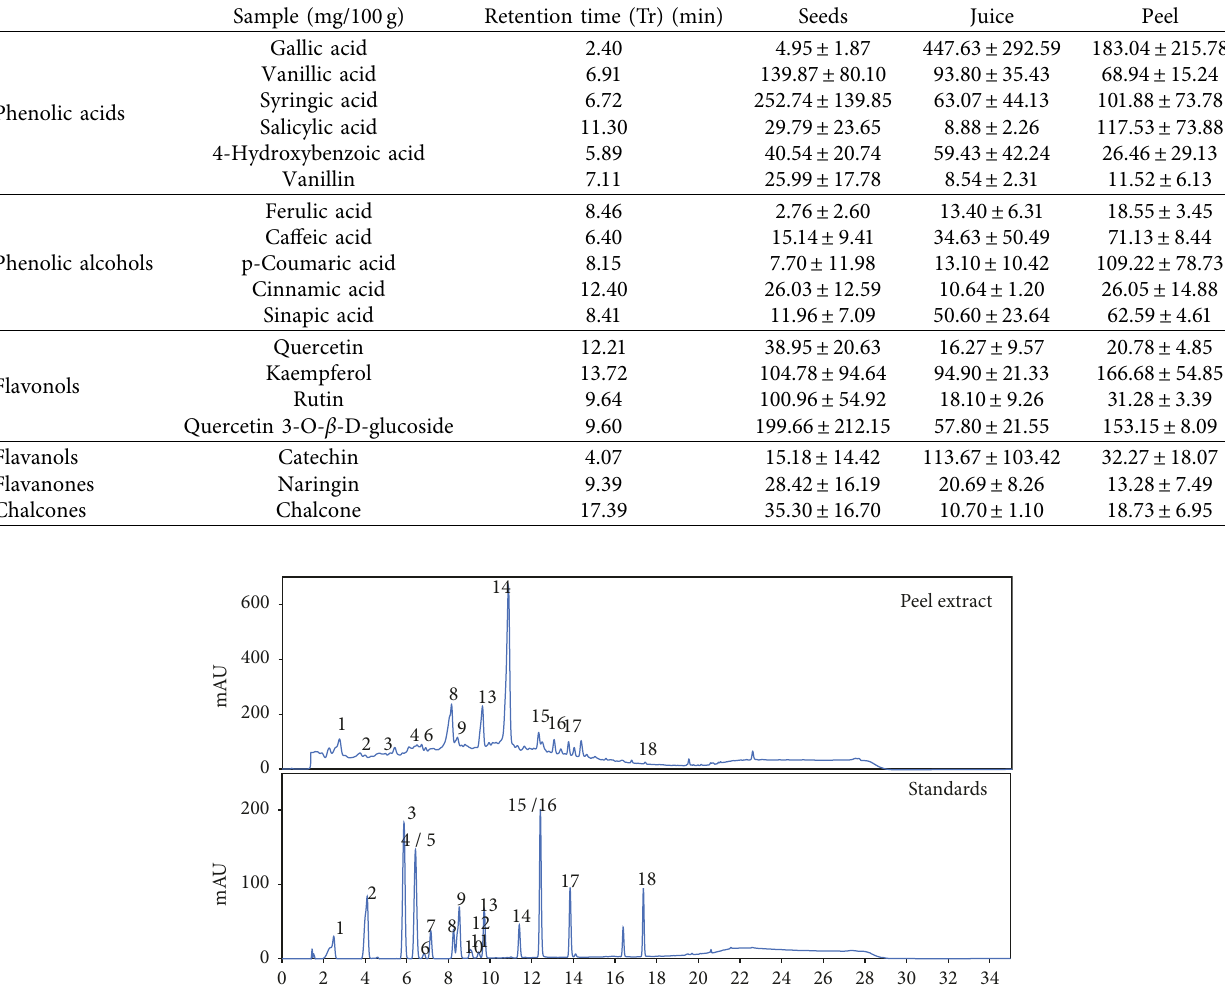
Table 4: HPLC-DAD analysis of the four families of phenolic compounds; phenolic acids, phenolic alcohols, flavonoids and chalcons; which were detected in seeds, juice and peel of ethanolic extracts of O. dillenii fruits harvested in Morocco.